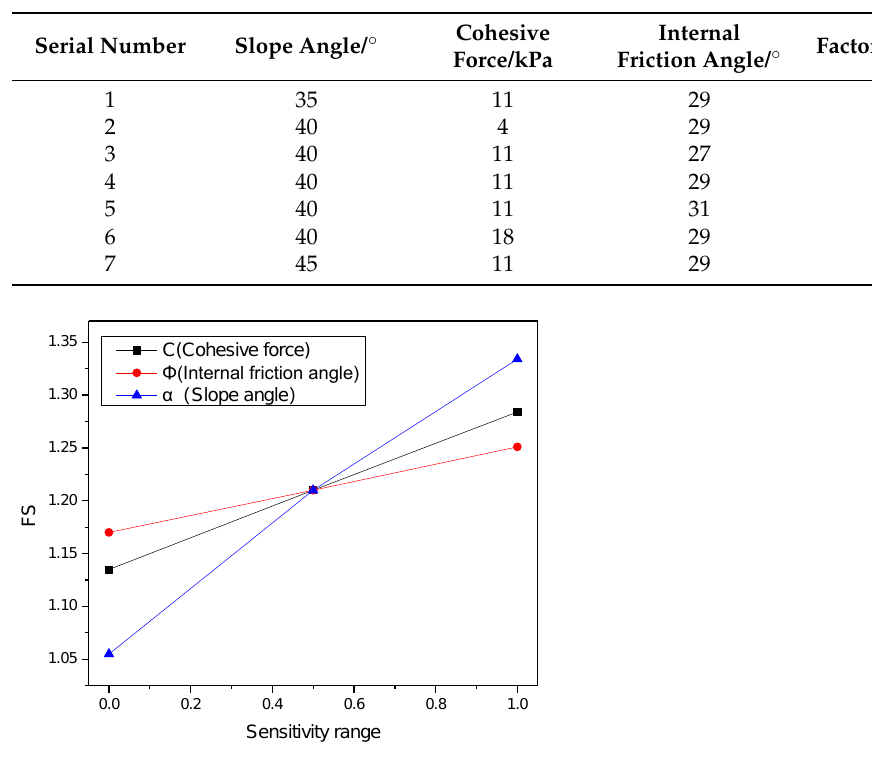
Table 3. Calculation results for sensitivity analysis.